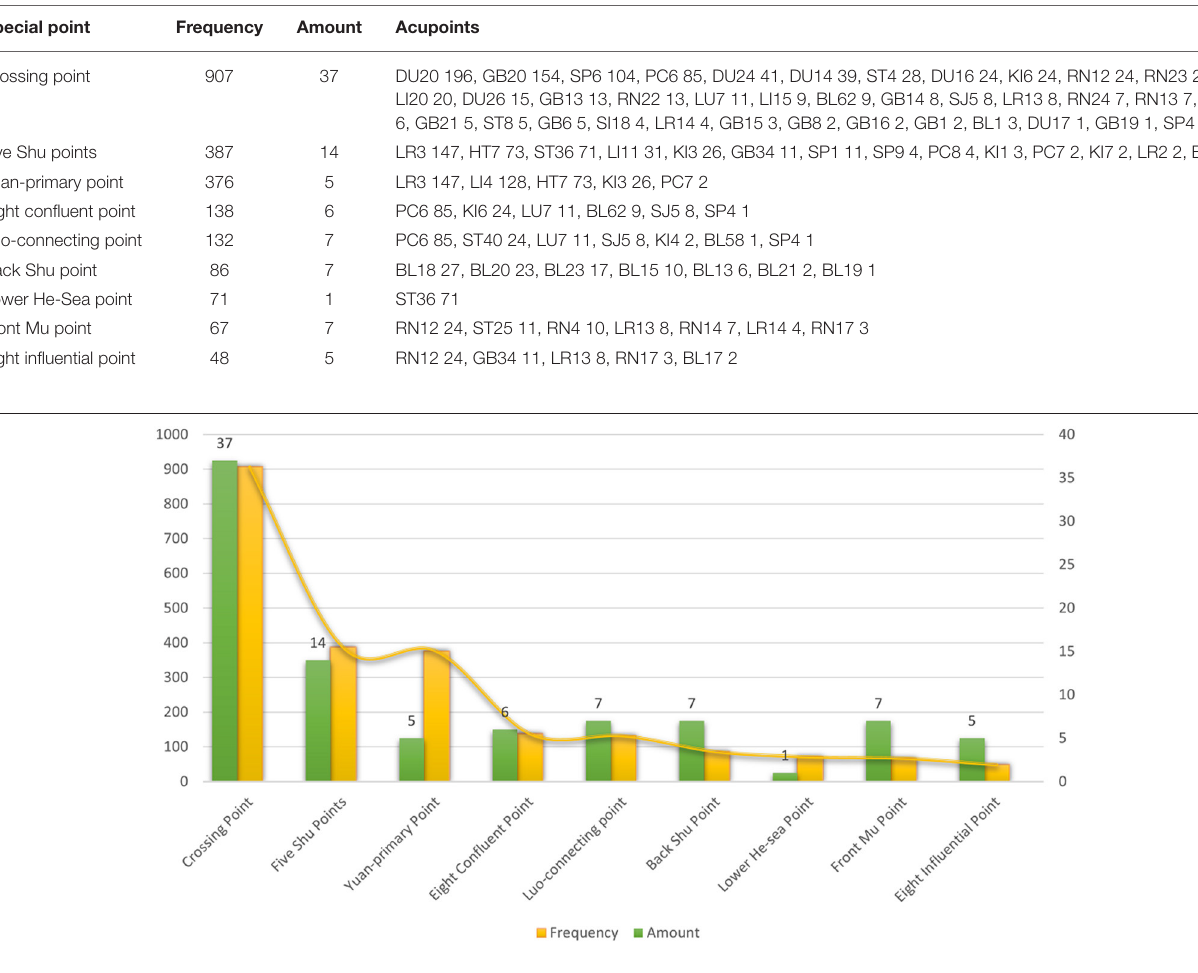
FIGURE 5 | Frequency of special point application for TD